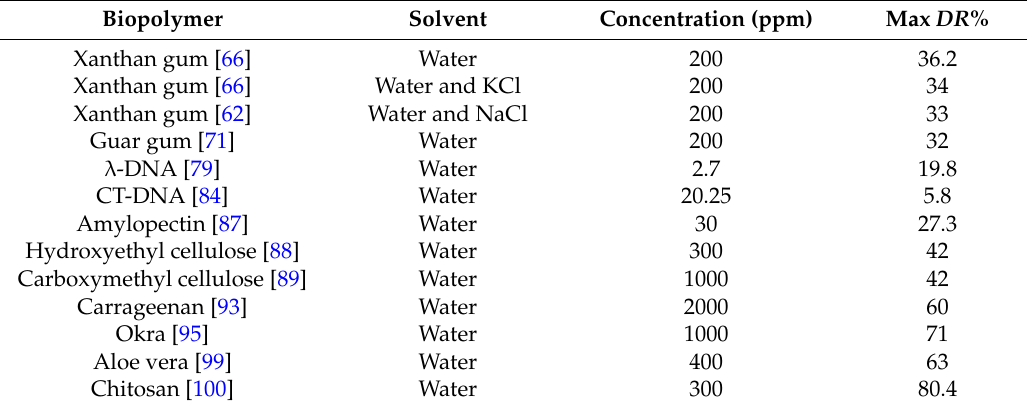
Table 1. Drag reduction performance of bio-polymer